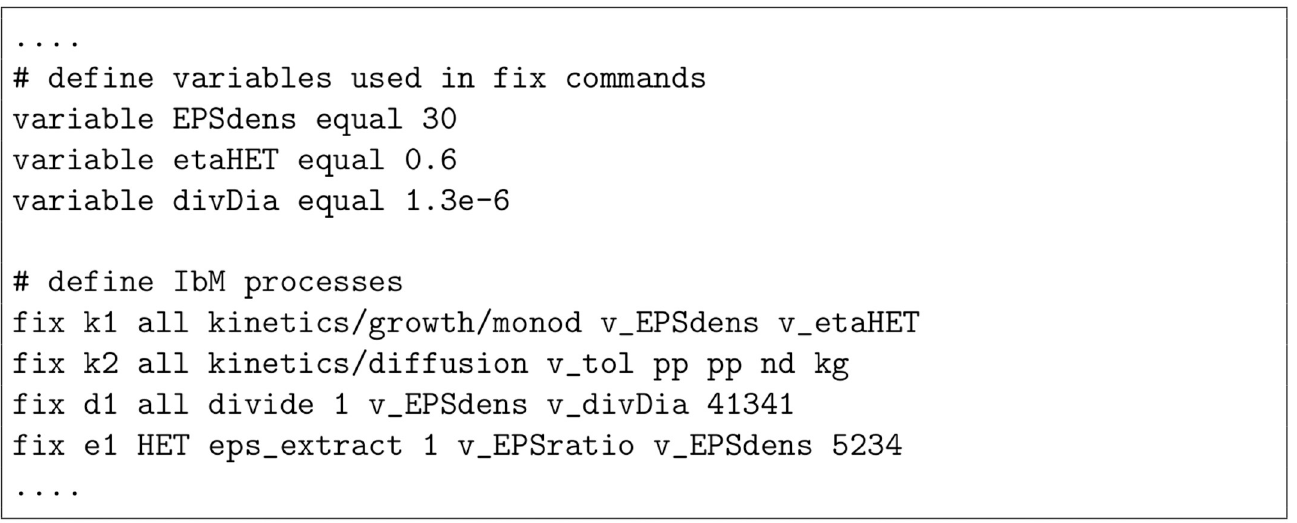
PLOS Computational Biology | https://doi.org/10.1371/journal.pcbi.1007125 December 12,